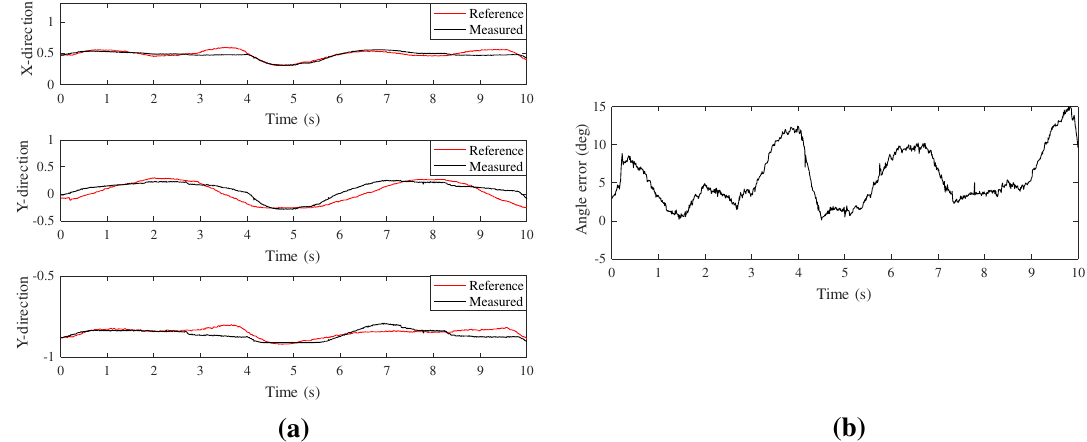
Figure 13. Experiment of the circumduction motion; ( a ) Orientation in the direction of x-, y- and z- axes; ( b ) Overall error of the